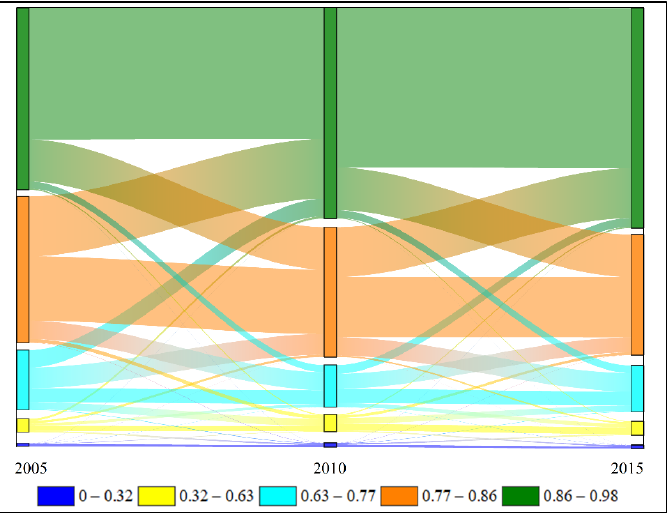
Table 8. Area transfer matrix of different FVC levels in the NFB from 2005 – 2015.